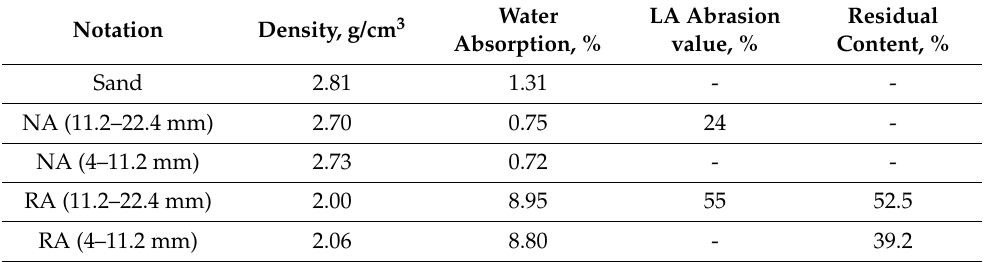
Table 2. The properties of natural aggregates.